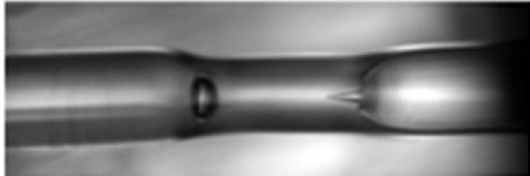
Figure 28. A micro-air cavity is formed by splicing hollow core PCF and SMF for curvature measurement (Reproduced from [90] with the permission of IOP science publishing).